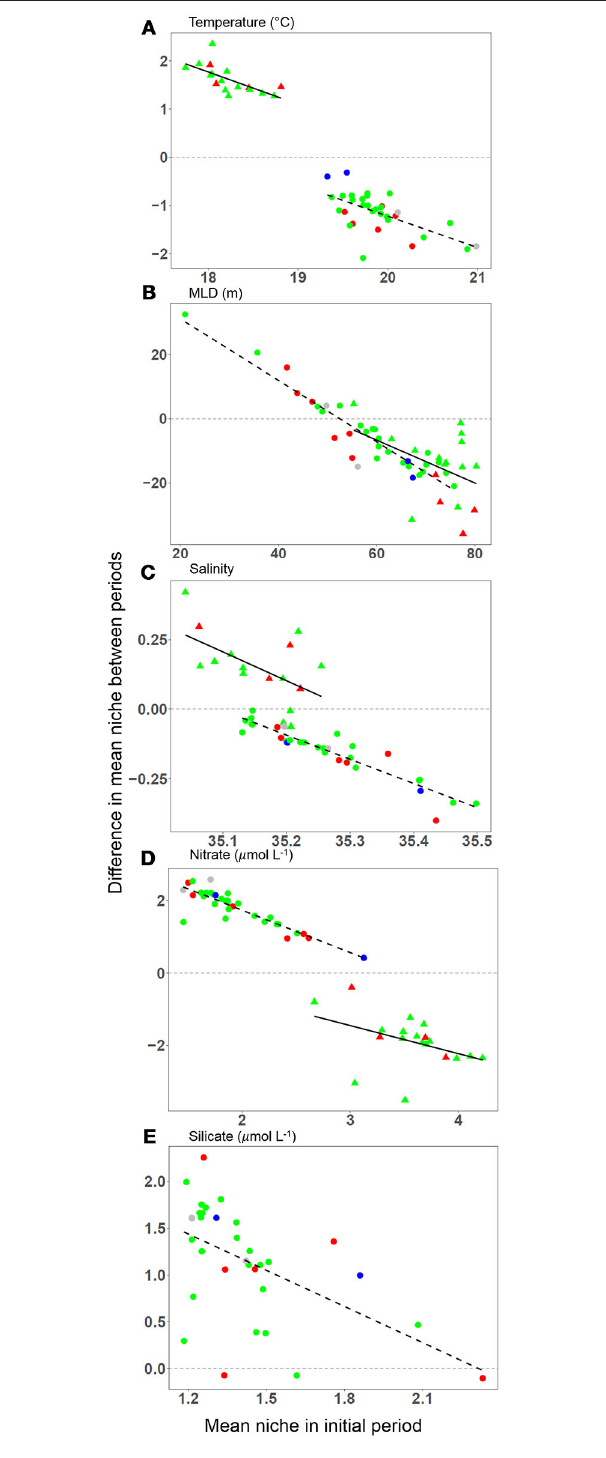
FIGURE 2 | Changes in the mean realized niche as a function of the mean niche in an initial period. Each panel displays changes for one variable between periods P1 and P2 (triangles) and between periods P2 and P3 (circles): (A) temperature ( ◦ C), (B) mixed layer depth (m), (C) salinity, (D) nitrate concentration ( µ mol L − 1 ), (E) silicate concentration ( µ mol L − 1 ). Each symbol